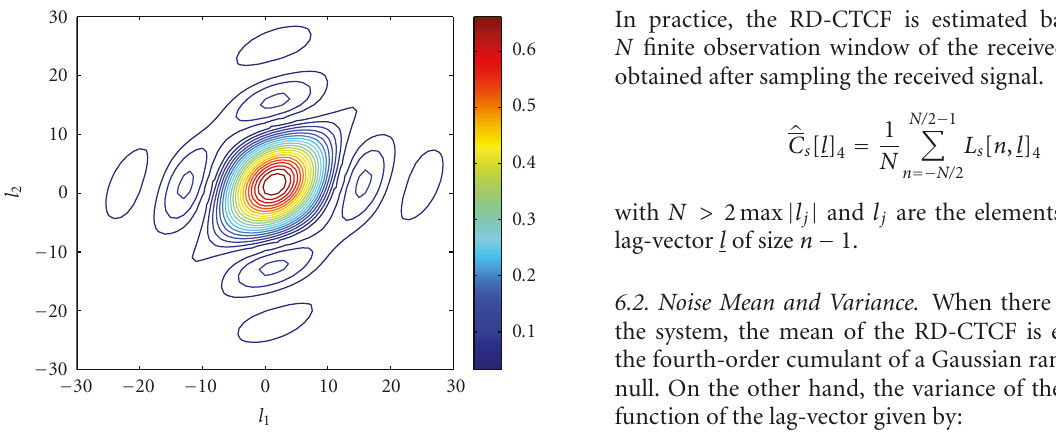
Figure 3: Fourth-order RD-CTCF of a 4-QAM baseband signal as a function of the lag parameters l 1 and l 2 for the cycle frequency 0. The values of l 0 and l 3 have been fixed to 0 and 3 respectively. The system parameters are: 1MHz symbol frequency, 10 MHz sample frequency, normalized square-root Nyquist pulse shaping filter of 0 . 2 roll-o ff